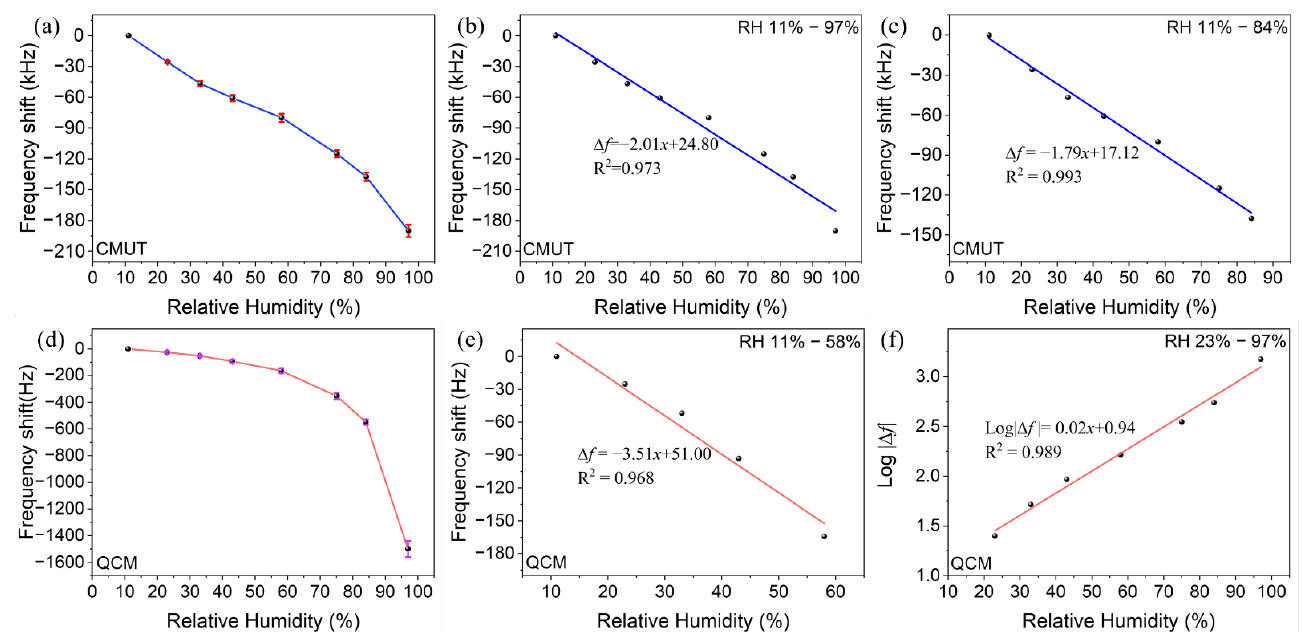
Figure 6. Sensitivity measurements of the CMUT sensor: ( a ) frequency shift as a function of RH from 11%RH to 97%RH. Error bars represent three replicate measurements; ( b ) correlation function curve between the frequency shift and RH from 11%RH to 97%RH; ( c ) correlation function curve between the frequency shift and RH from 11%RH to 84%RH. Sensitivity measurements of the QCM sensor: ( d ) frequency shift as a function of RH from 11%RH to 97%RH. Error bars represent three replicate measurements; ( e ) correlation function curve between the frequency shift and RH from 11%RH to 58%RH; ( f ) correlation function curve between the logarithmic frequency shift and RH from 23%RH to 97%RH.